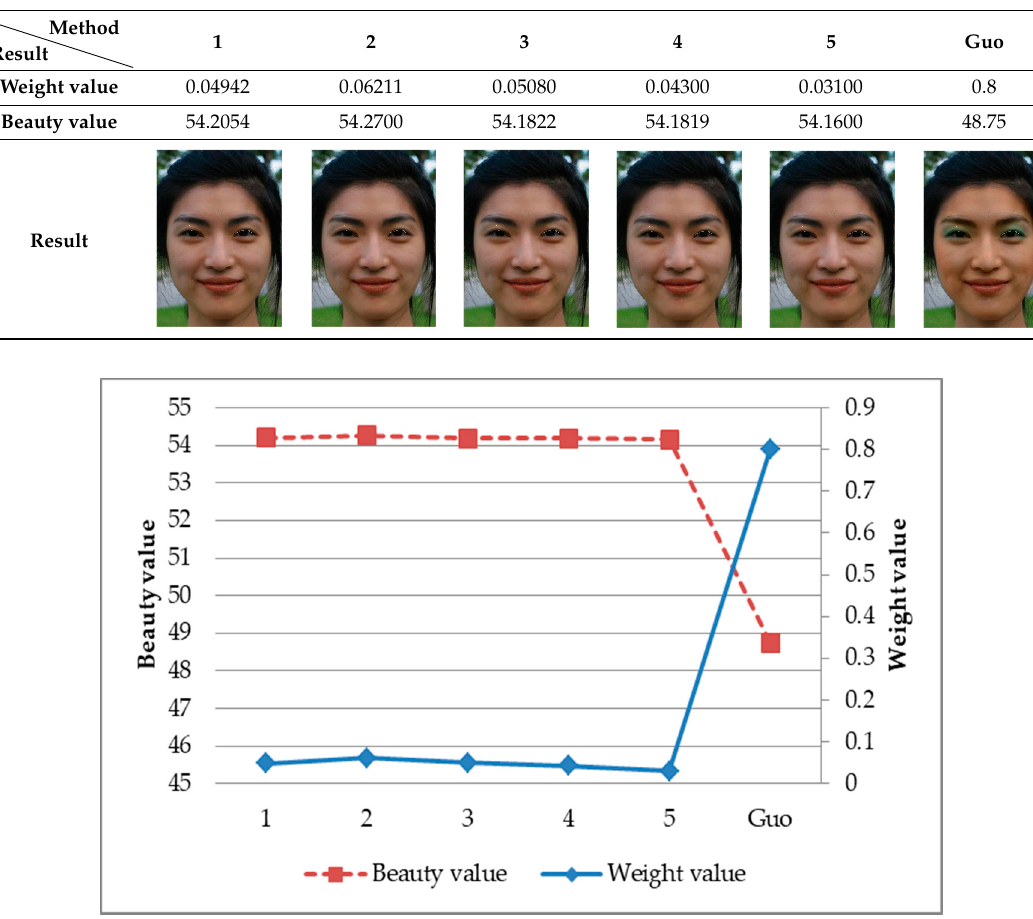
Table 3. Comparison between Guo and ours.